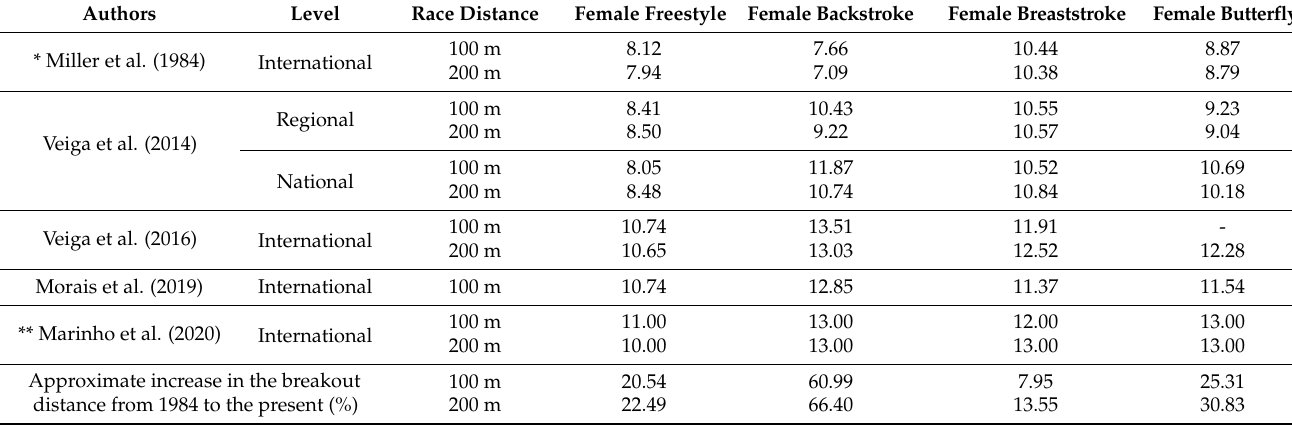
Table 3. Breakout distance after the start in the four swimming strokes in 1984 and recent years in female events (the numbers in the table only show the mean value presented in each